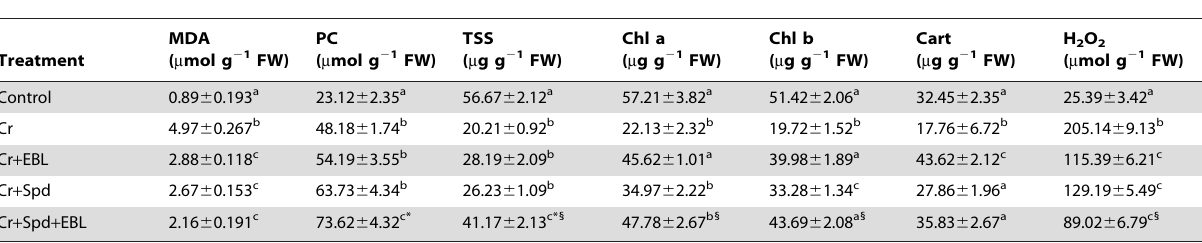
Table 4. Effect of EBL and/or Spd on endogenous levels of stress indicators in radish seedlings under Cr-stress.